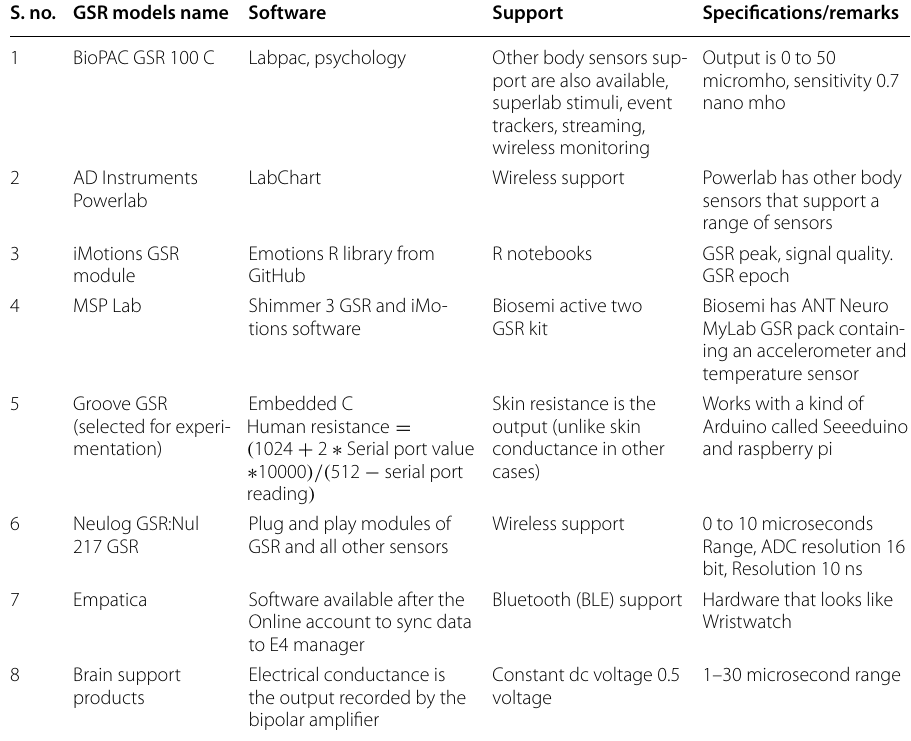
Table 2 A market survey of available galvanic skin sensor trademark models S. no. GSR models name